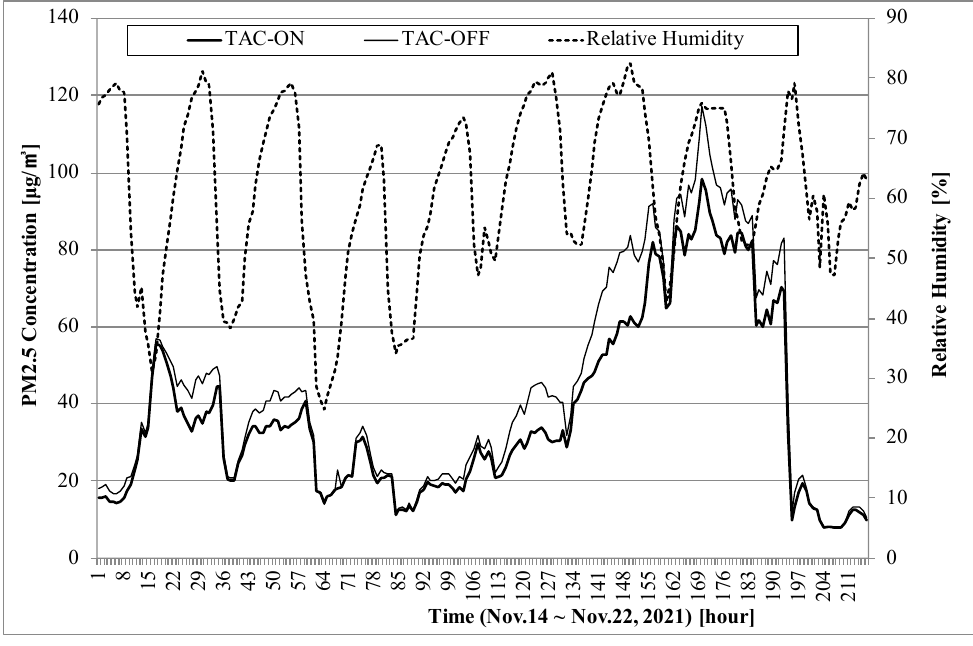
Figure 6. PM concentrations of two TAM devices with TAC-on and TAC-off from 14–22 November